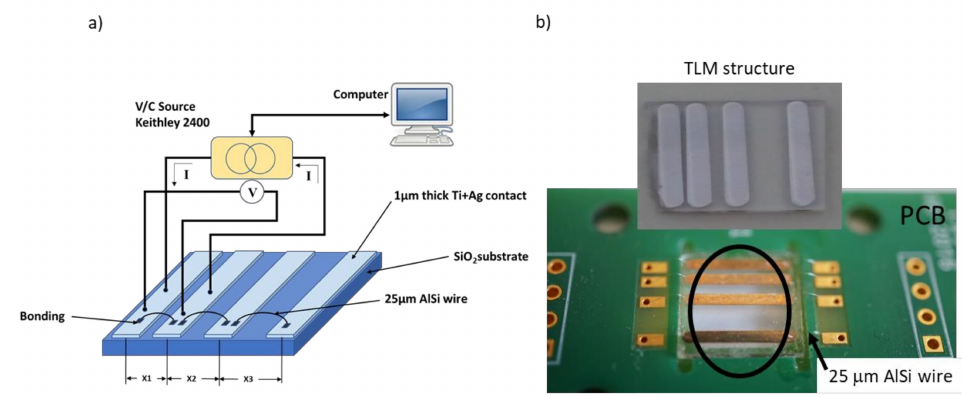
Figure 4. ( a ) Scheme of the home-made system for transmission line method (TLM) method used to calculate the contact resistances after the wire bonding, and ( b ) photograph of the sample connected to the PCB with the AlSi wires.